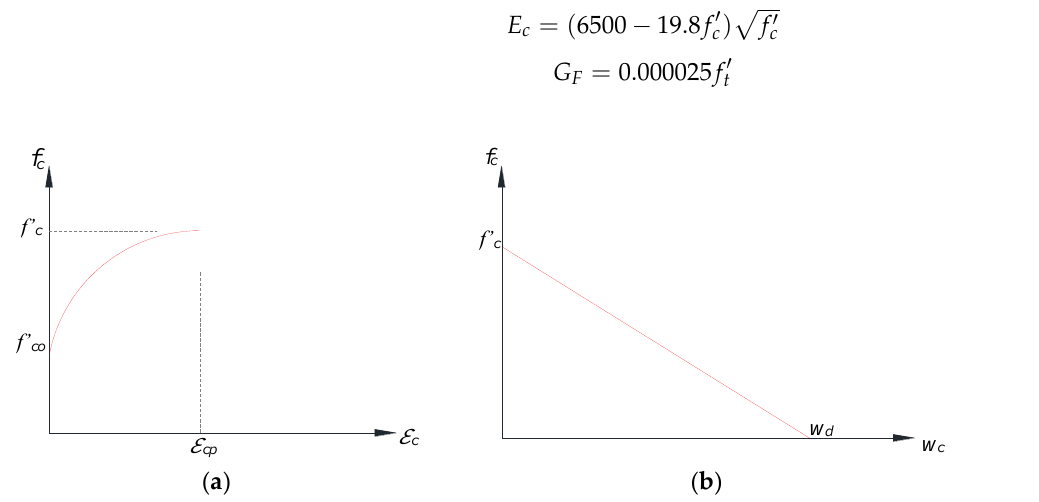
Figure 6. The softening/hardening plasticity constitutive model: ( a ) hardening law, and ( b ) softening law [14]. Table 2. Main parameters of concrete and grout constitutive models.